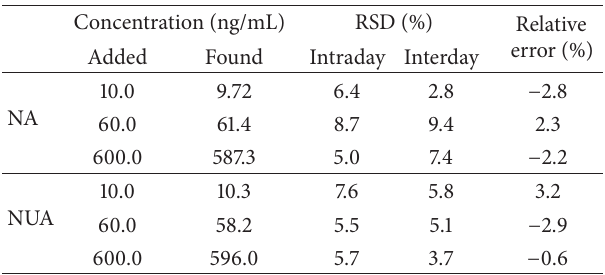
Table 1: Precision and accuracy for the analysis of NA and NUA in quality control (QC) samples ( 𝑛 = 3 days, 6 replicates per day) in human